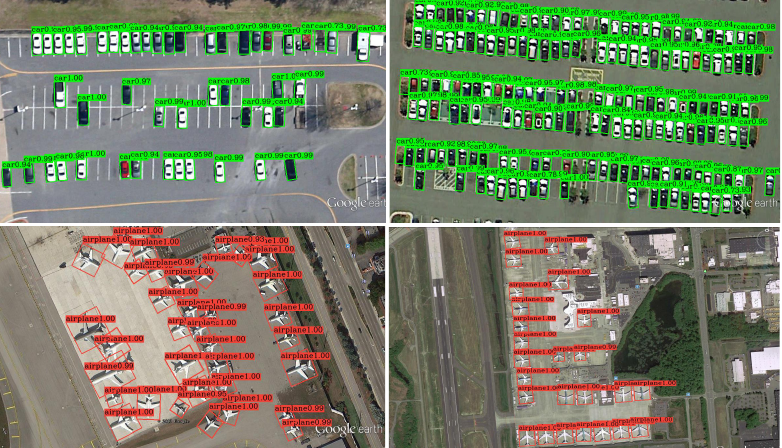
Figure 9. Visualization of detections on UCAS-AOD